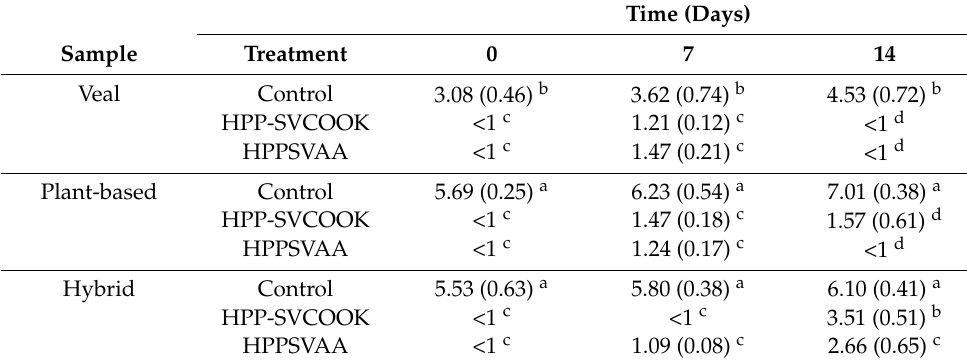
Table 6. Enterobacteriaceae counts (mean of log cfu/g (standard deviation)) in the veal, plant-based, and hybrid patty during the 0, 7, and 14 days after